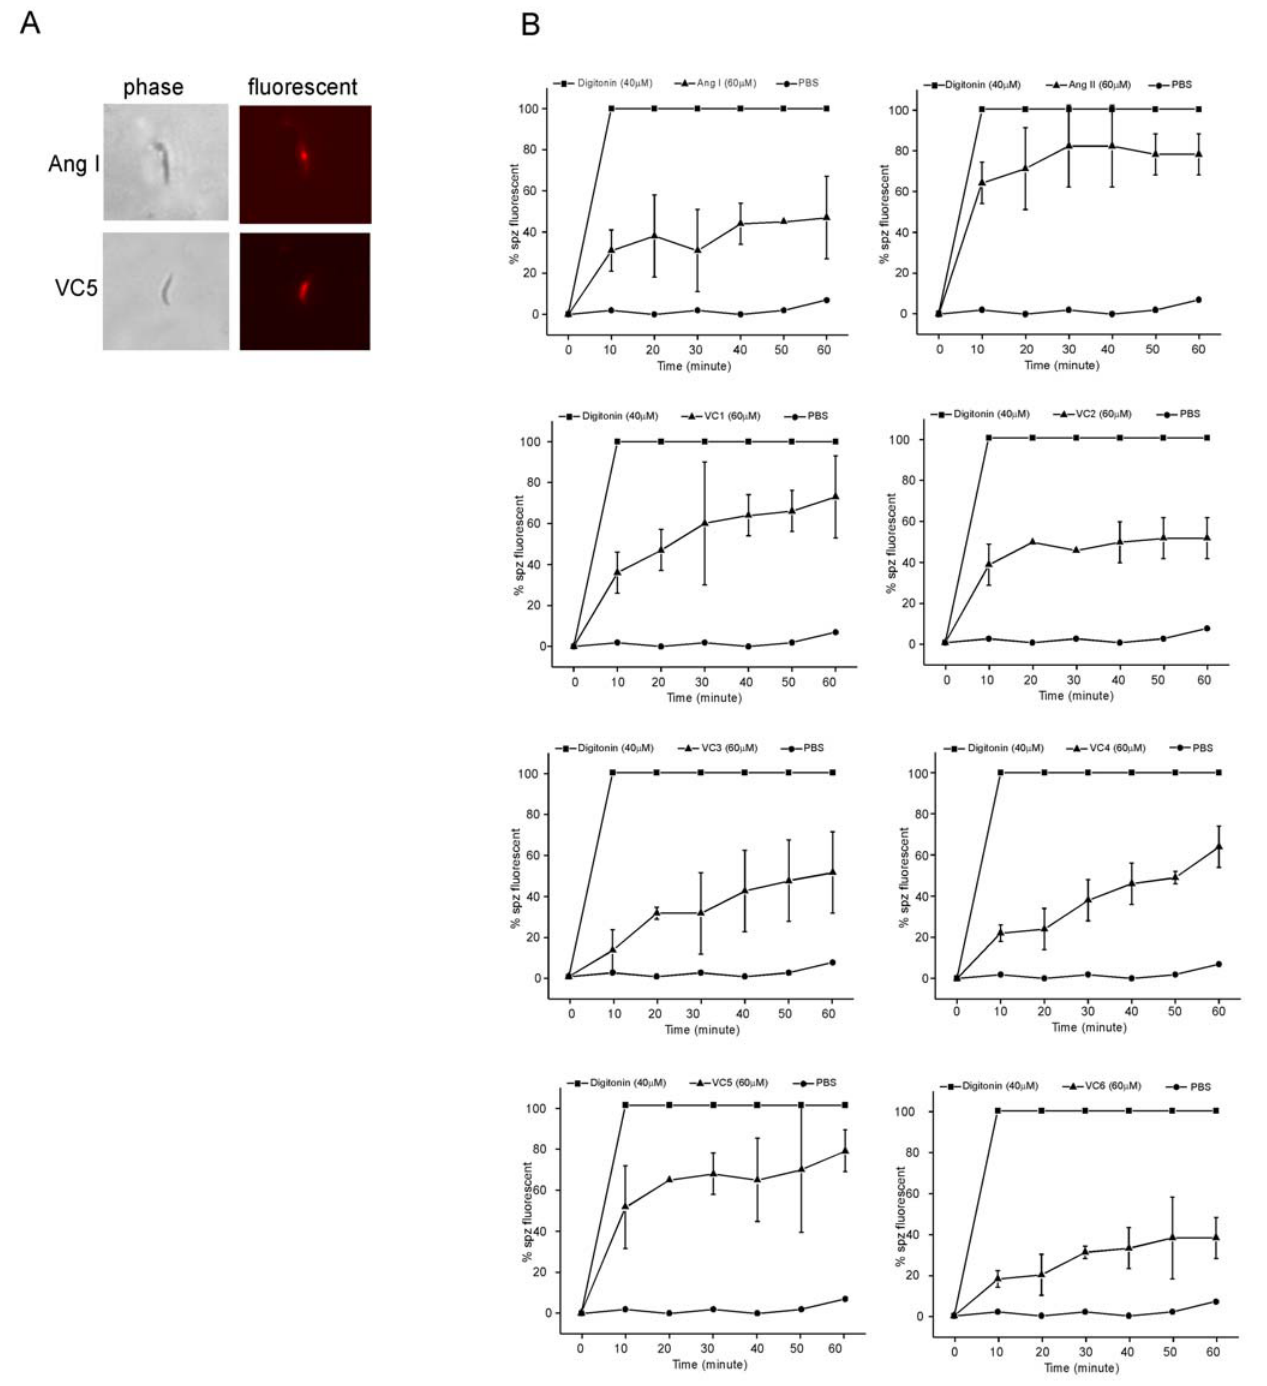
Figure 2. Effects of peptides on membrane permeability of mature sporozoites were incubated with digitonin, PBS, 60 m M of ang I, ang II, VC1, VC2, VC3, VC4, VC5 or VC6. After defined intervals at room temperature, propidium iodide was added and the sporozoites were examined by fluorescent microscopy. A, sporozoites in phase (left) and fluorescent (right) microscopy; B, kinetic curves of membrane fluorescence. Results are the mean of three independent experiments, and bars represent standard errors of the mean. The data were statistical analyzed (60 min) using Fisher’s test showing that ang II, VC1 and VC5 are significant different ( p , 0.02) when compared with control. On the other hand, ang I, VC2, VC3, VC4 and VC6 are not significantly different ( p . 0.05).